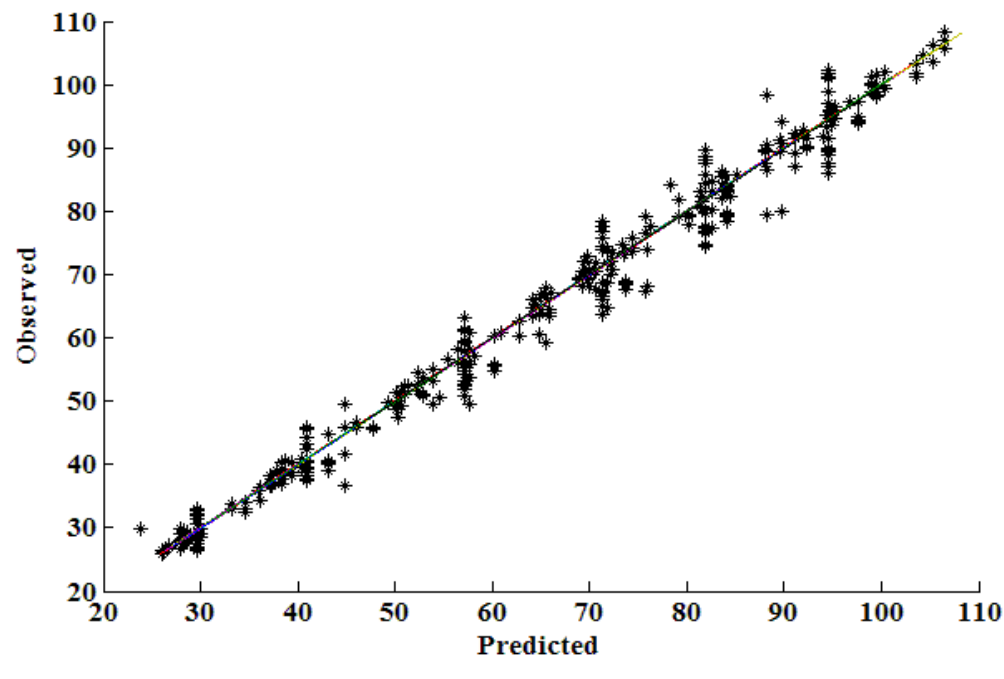
Figure 5. Comparison of correlation coefficients for predicted vs. observed